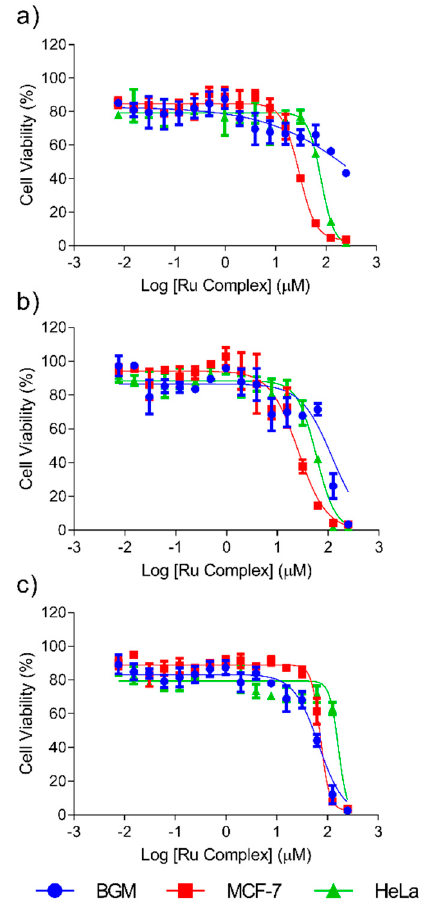
Figure 1. Dose–response curves of HeLa, MCF-7 and BGM cells treated with complexes II ( a ), VI ( b ) and III ( c ) for 48 h.